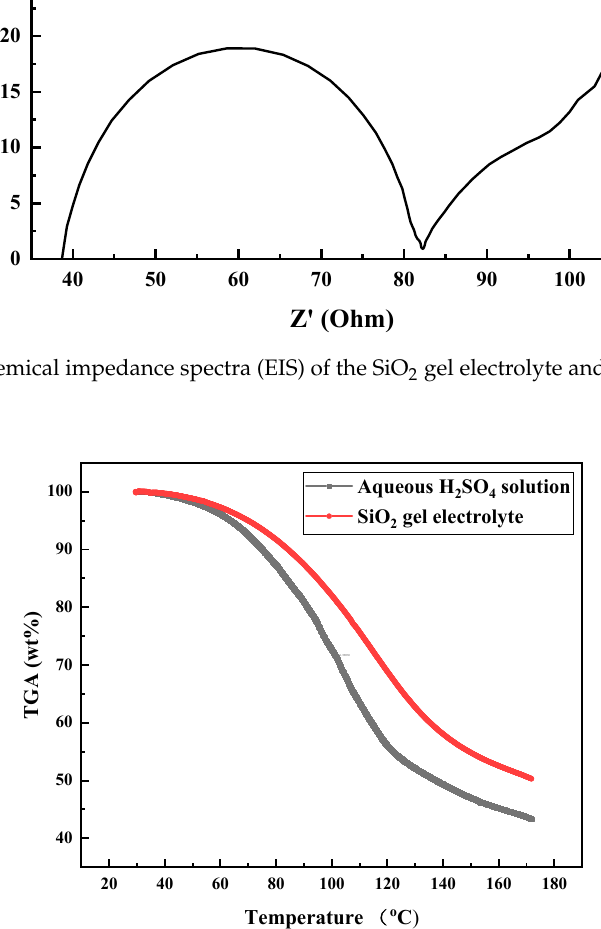
Figure 6. TGA curves of the SiO 2 gel and aqueous H 2 SO 4 solution electrolytes.